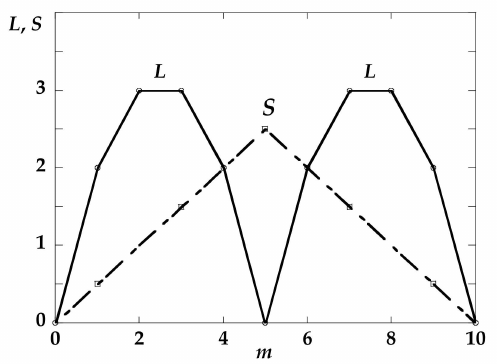
Figure 1. Values of spin S and orbital L momenta of an isolated transition ion, characterized by electronic shells 3 d m , 4 d m or 5 d m (1 ≤ m ≤